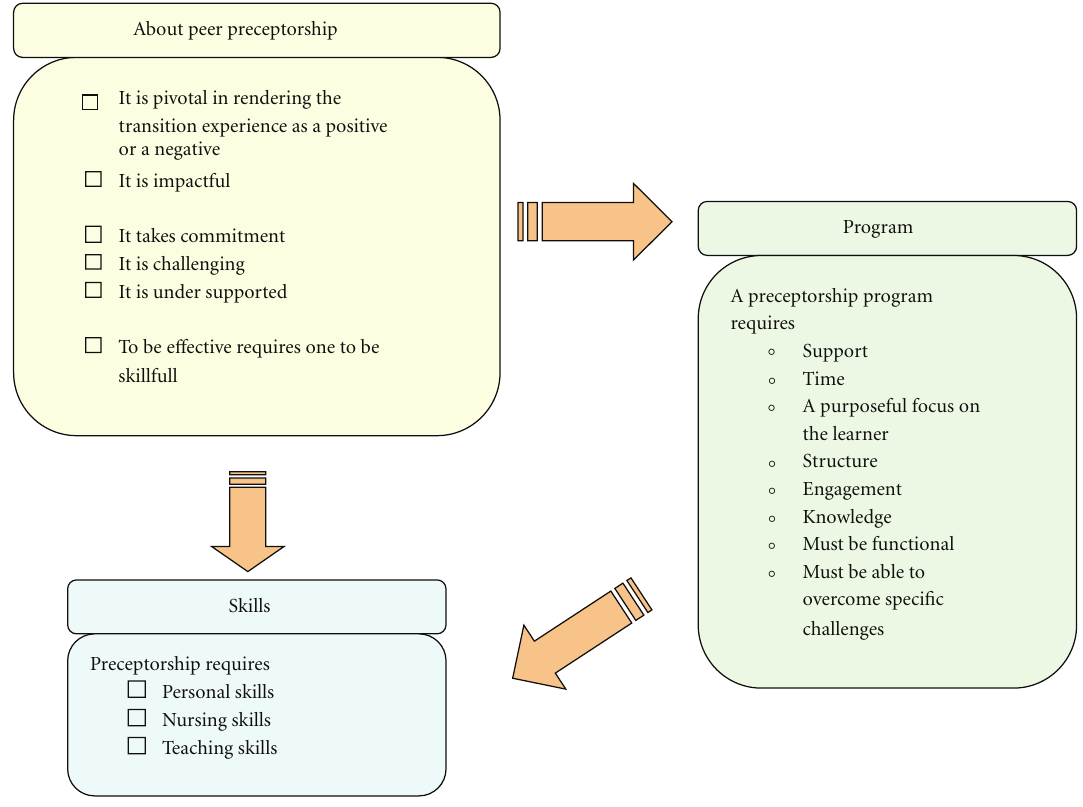
Figure 4: Three categories that emerged from the